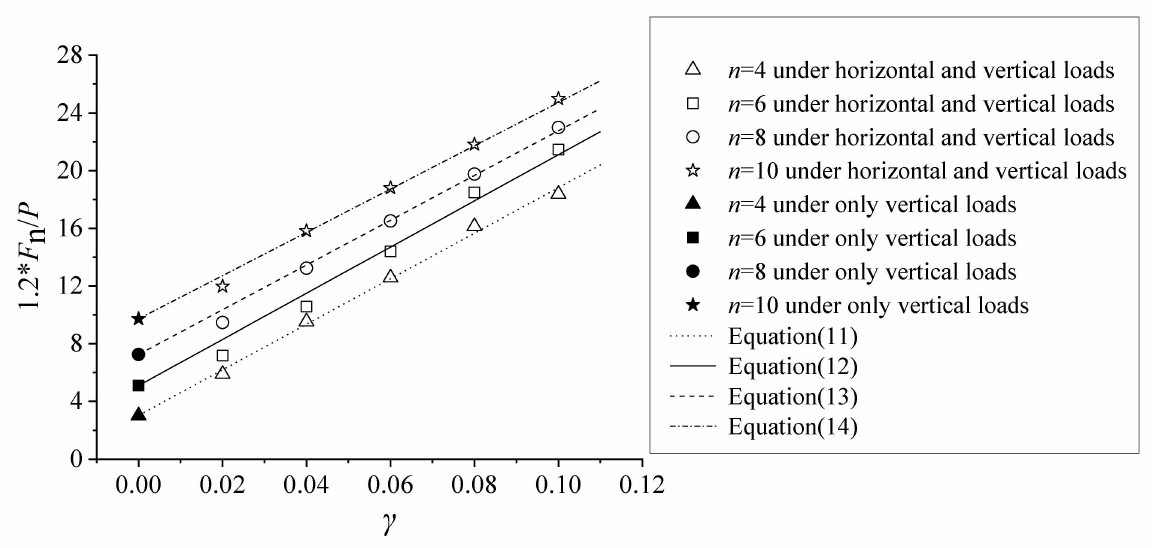
Figure 10. Variation in 1.2 × F n / P against γ